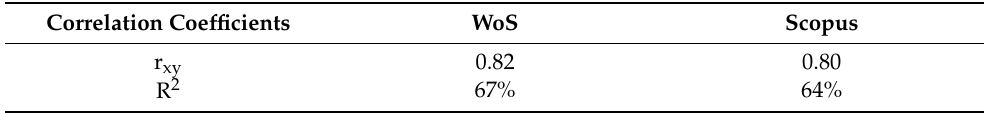
Table 4. Pearson’s coefficient and coefficient of determination for the analyzed population of publica-